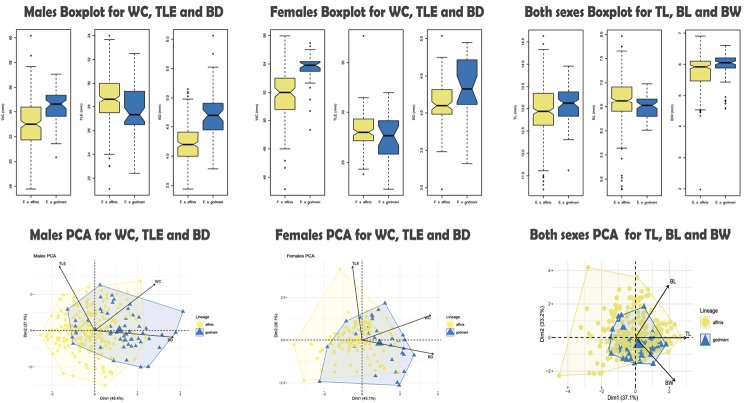
Morphometric analyses results. A) Females boxplots and PCA for WC, TLE, and BD morphometric characters. B) Males boxplot and PCA for WC, TLE, and BD morphometric characters. C) Boxplot and PCA for TL, BL, and BW. WC, TLE, and BD characters were analyzed by separated sex, because the analyses indicated sexual dimorphism (see results and Table 3). Bill length (BL, from the upper base of the bill to the tip of the upper mandible), bill width (BW), bill depth (BD, from the upper mandible to the base of the bill at the distal edge of the nostrils), wing chord (WC, distance from the carpal joint the tip of the longest primary), tarsus length (TL), and tail length (TLE, distance from the uropygial gland to the tip of the longest rectrix).